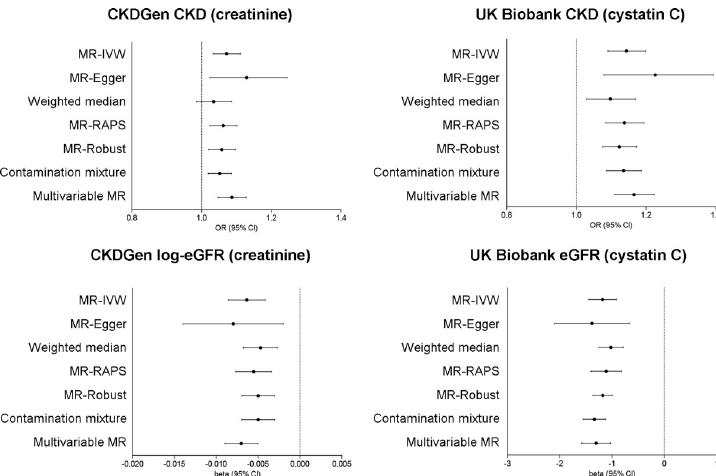
Fig 3. Causal estimates of adult height on kidney function traits in the CKDGen GWAS meta-analysis (N = 567,460) and UK Biobank GWAS (N = 321,405). Kidney function parameters (eGFR and CKD) were based on serum creatinine values in the CKDGen GWAS meta-analysis and on serum cystatin C levels in the UK Biobank GWAS. eGFR was log-scaled in CKDGen data, and raw continuous values were used for UK Biobank data. Multivariable MR was performed with adjustment of the genetic effects of genetic instruments for body mass index. GWAS = genome-wide association study, eGFR = estimated glomerular filtration rate, CKD = chronic kidney disease. MR = Mendelian randomization, MR-IVW = Multiplicative random effect inverse variance weighting, MR-RAPS = Mendelian randomization-robust adjusted profile score, OR = odds ratio, CI = confidence interval.